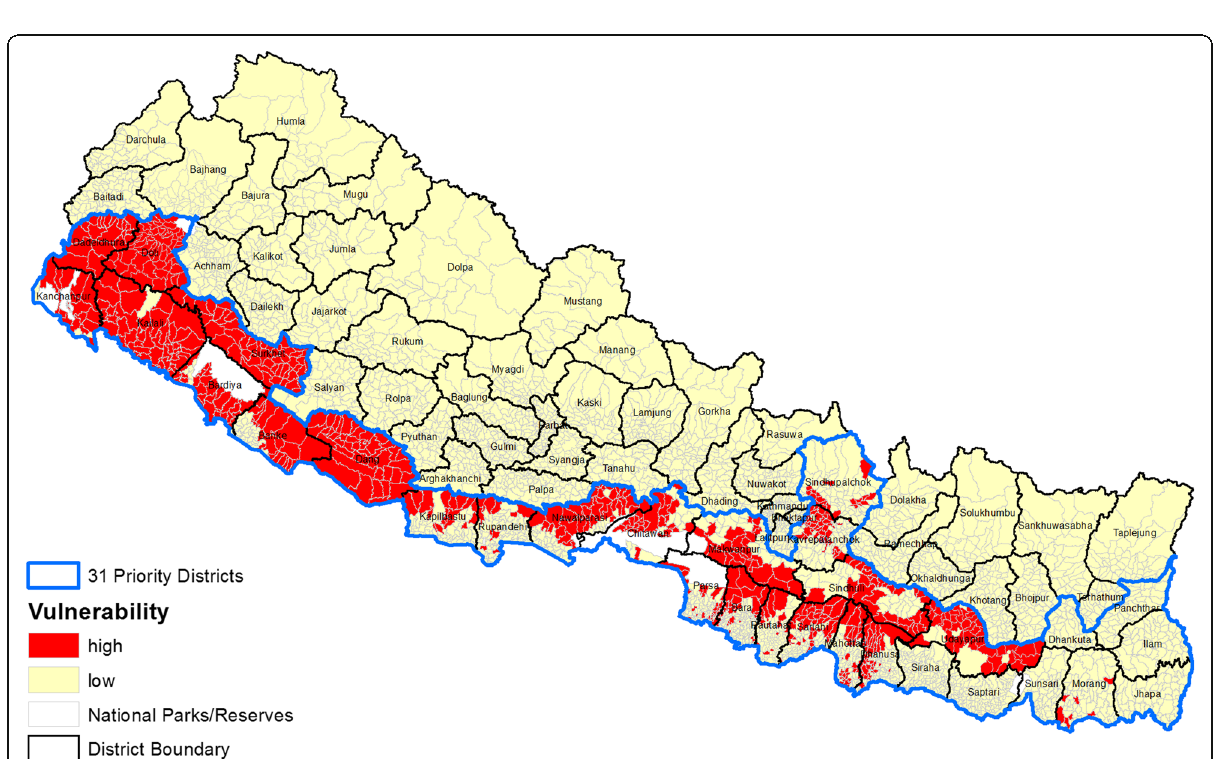
Fig. 6 Vulnerability due to population movement